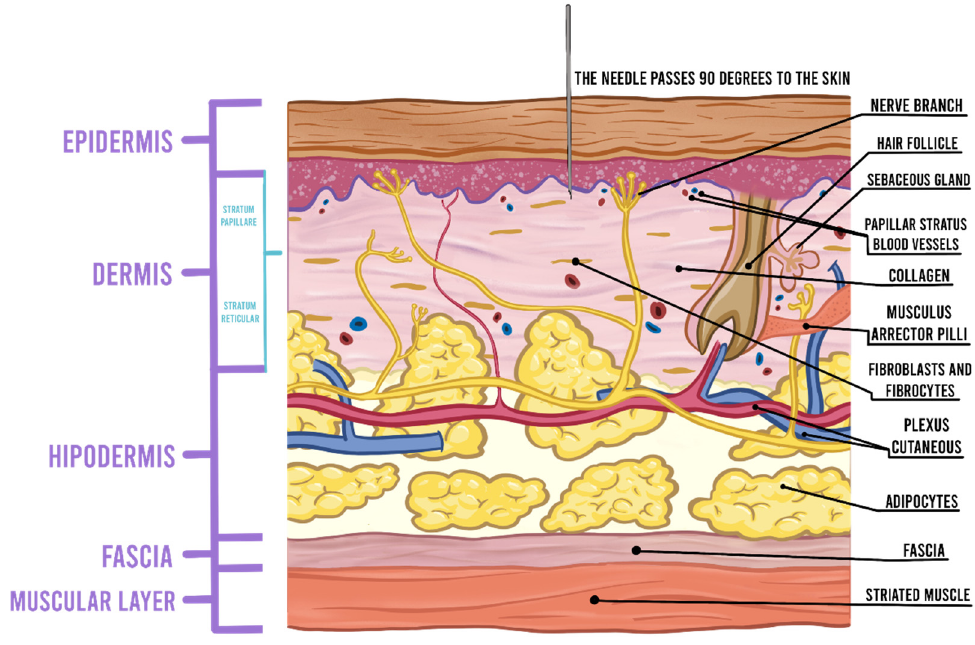
Figure 2. Needle insertion at a 90-degree angle during skin penetration passes through fewer pain fibers and reduces injection pain.